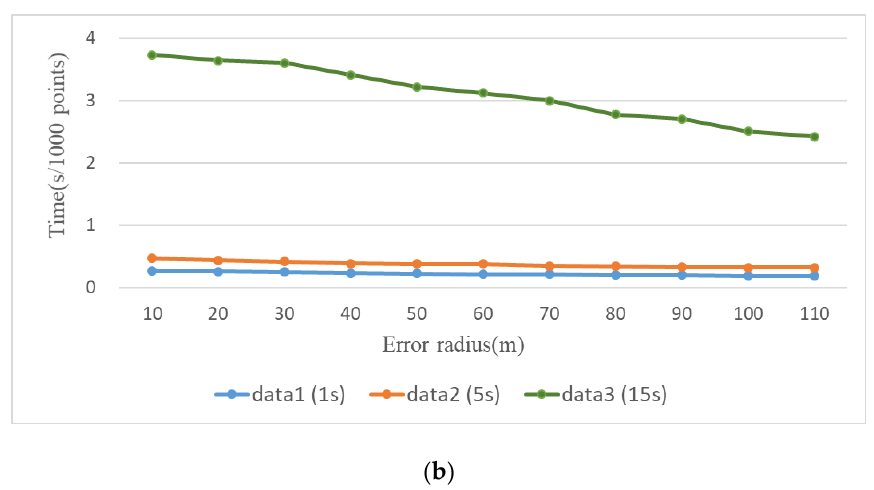
Figure 8. Comparison of the proposed method’s efficiency at the eleven error radii: ( a ) The total running time of each trajectory data, and ( b ) the average running time per 1000 points of trajectory data.